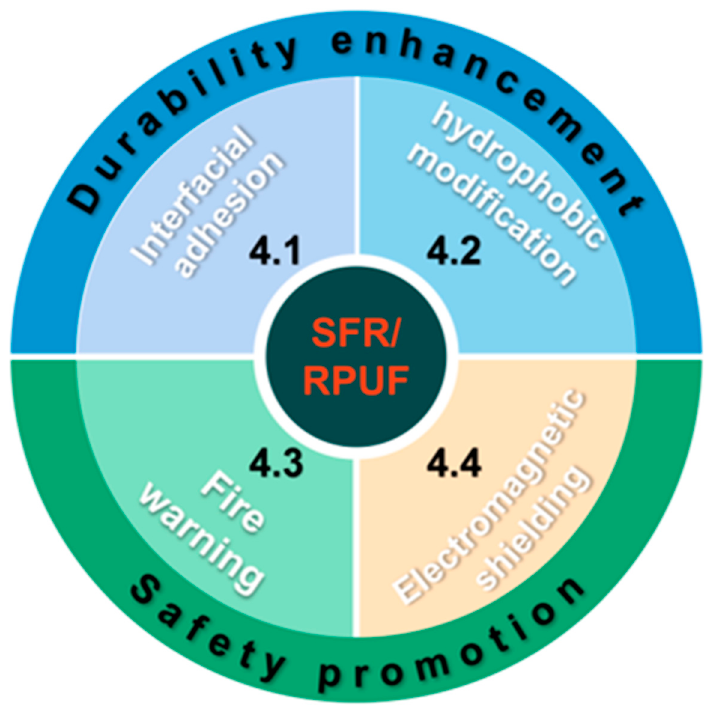
Figure 13. Illustration of the SFR/RPUF modification.